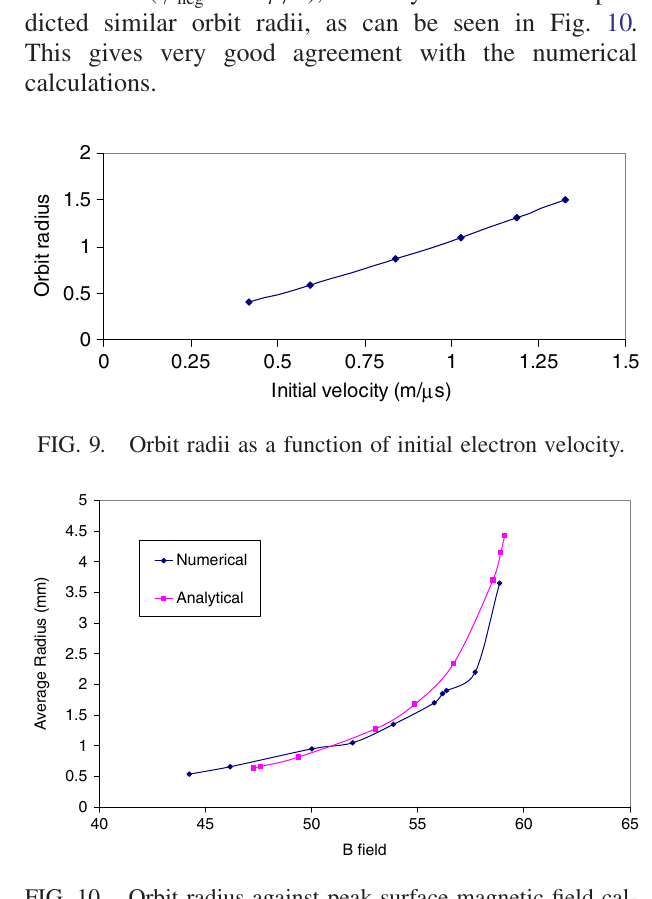
FIG. 10. Orbit radius against peak surface magnetic field cal- culated using tracking code and with analytical calculations.